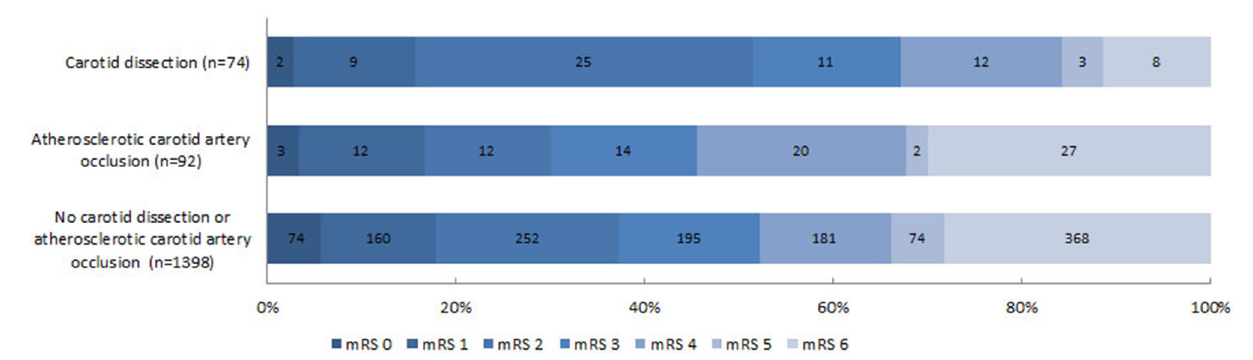
P -value CAD vs. without CAD or